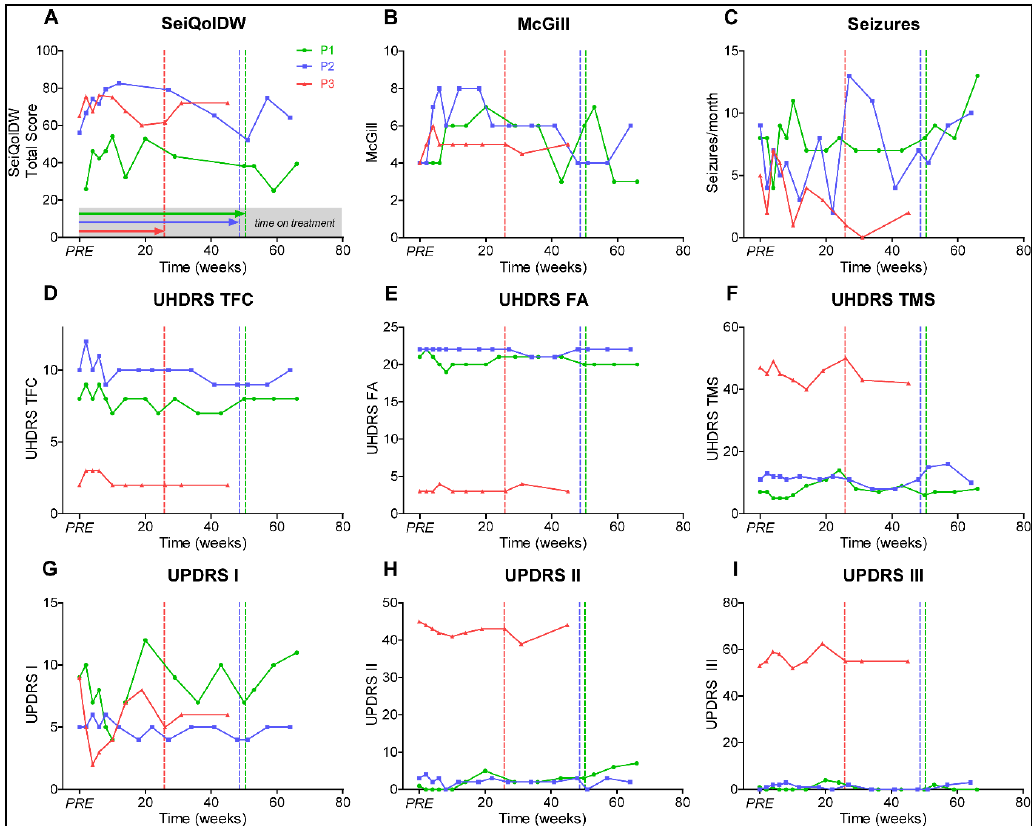
Figure 2. Graphs represent ( A ) Schedule for the Evaluation of Individual Quality of Life-Direct Weighting (SEIQoL); ( B ) McGill Quality of Life Single-Item Scale (McGill); ( C ) seizure frequency per month; ( D ) Unified Huntington’s Disease Rating-Scale Total Functional Capacity (UHDRS TFC); ( E ) UHDRS Functional Assessment Scale (UHDRS FA); ( F ) UHDRS Total Motor Scale (UHDRS TMS); ( G ) Movement Disorders Society Unified Parkinson‘s Disease Rating Scale part I (UPDRS I); ( H ) MDS-UPDRS part II (UPDRS II); and ( I ) MDS-UPDRS part III (UHDRS III). Patients 1–3 (P1–3), PRE represents baseline value before initiation of dasatinib treatment, dotted vertical lines represent individual end of treatment.